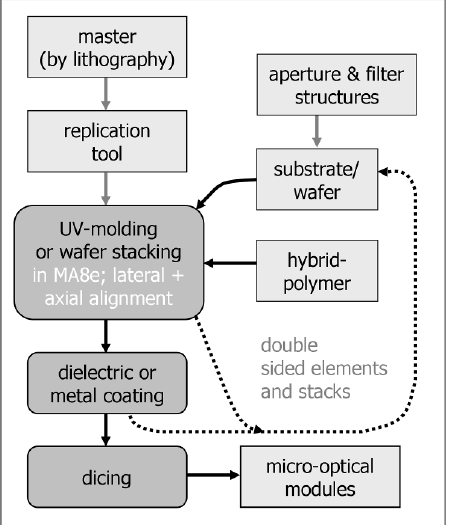
Figure 1. Flowchart of the technology based on UV-molding, coating, and lithography.